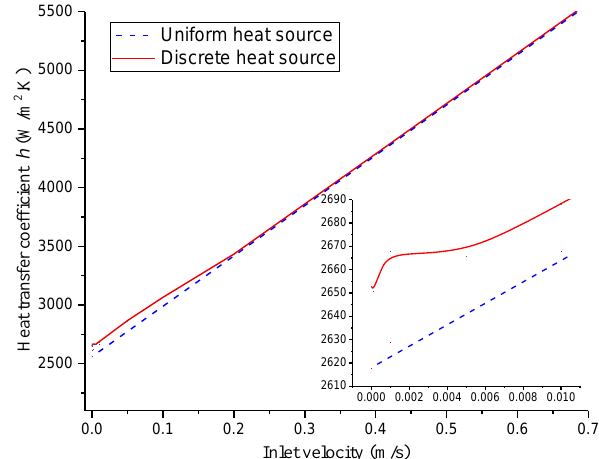
Figure 8. The temperatures with the velocity vector for various inlet velocity when q = 5 × 10 5 W/m 2 . Table 4. The highest temperatures on the wall with heat source for various inlet velocities and heat fluxes.